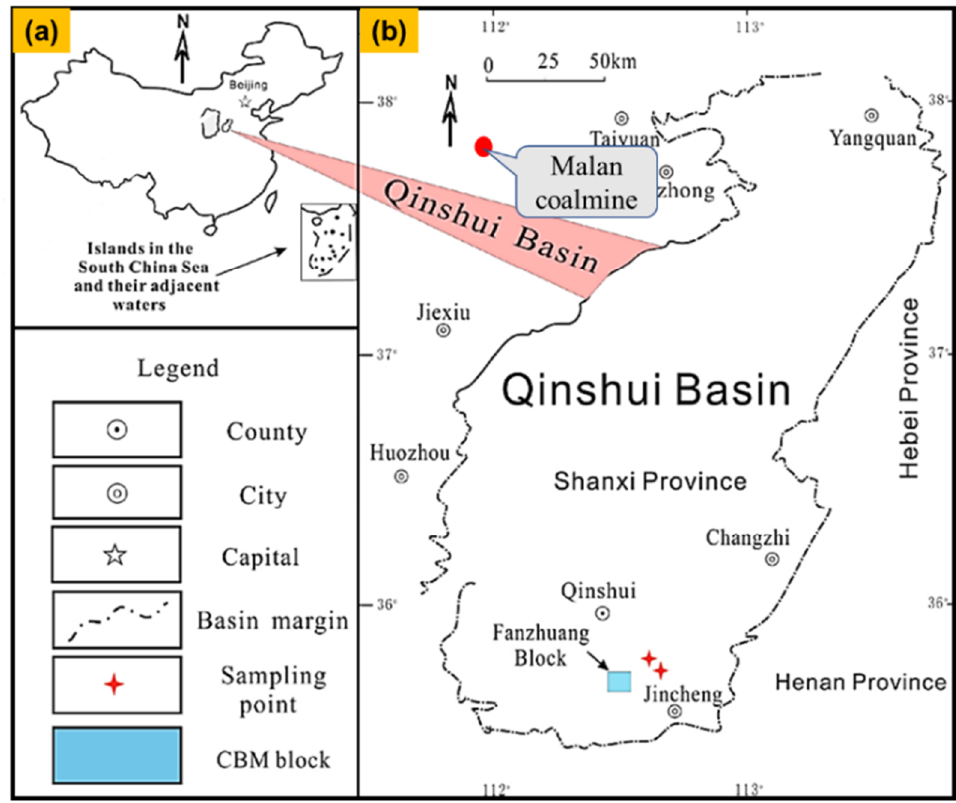
Figure 2. Maps of the Qinshui Basin ( a ) and the Malan coalmine ( b ) (modified from [22]).